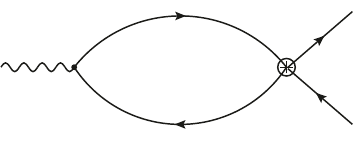
Figure 1 . The diagram corresponding to the leading short-distance contribution to the operator- product expansion of the time-ordered product in eq. (2.15). The external lines correspond to the insertion of the current j (cid:22) ( x ) (wiggly line) and of the quark (cid:12)elds d and (cid:22) s . The circled